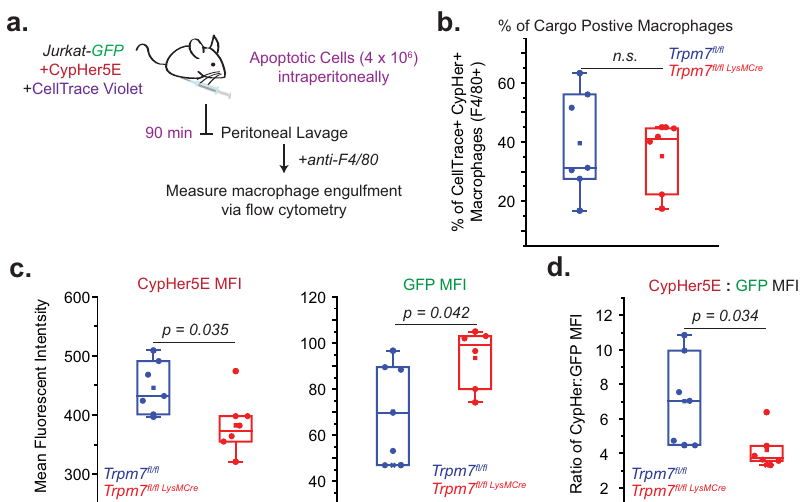
Fig. 4 Degradation of apoptotic cell cargo by peritoneal macrophages requires TRPM7. a The experimental design to measure apoptotic cell clearance in vivo is schematized. b Quanti fi cation of engul fi ng peritoneal macrophages (F4/80 + ) in Trpm7 fl / fl ( n = 8) and Trpm7 fl / fl LysM Cre ( n = 7) mice during in vivo clearance of apoptotic Jurkat-GFP cells. c MFI of CypHer5E, which measures cargo acidi fi cation (left) and GFP, which is stably expressed in Jurkat- GFP cells (right). See also Supplemental Fig. 3 for gating strategy. d Quanti fi cation of cargo degradation by WT and KO peritoneal macrophages in vivo as depicted by the ratio of CypHer5E MFI to GFP MFI in Cargo + peritoneal macrophages. Dots represent independent samples from individual mice in n = 3 independent experiments. Box charts display sample distribution and are described in Methods. Source data are provided as a Source Data fi le, and statistical testing is described in “ Statistics and Reproducibility ”